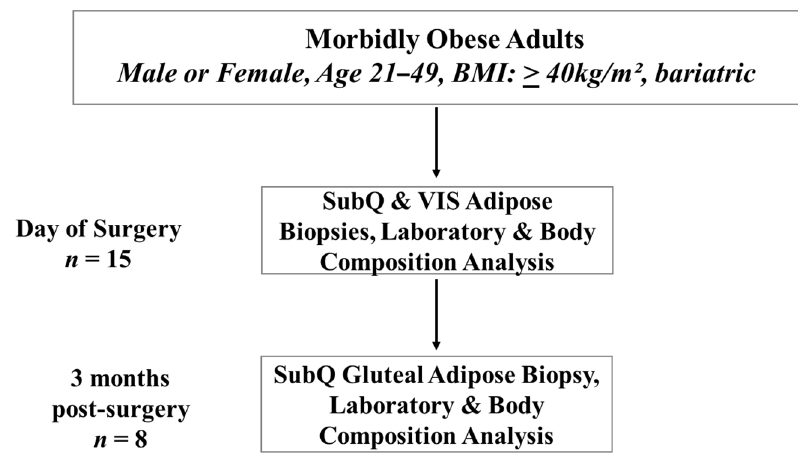
Figure 1. Study flow chart.